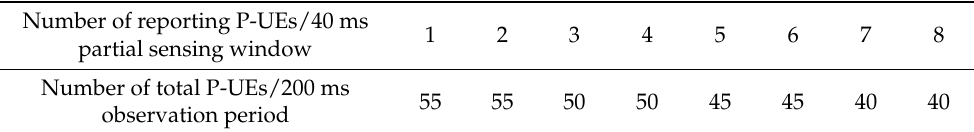
Table 1. The number of P-UEs that can be served by the proposed method according to the number of P-UEs reporting their partial sensing results to the